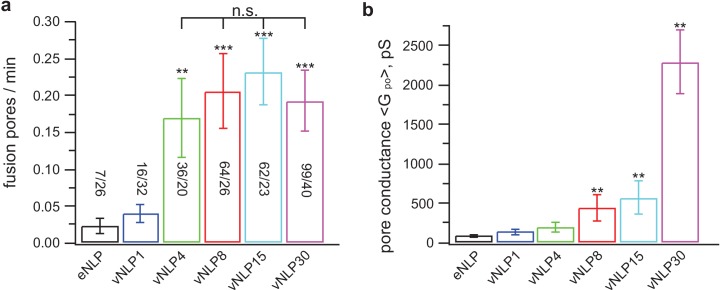
Only a few SNARE complexes are required to nucleate a pore, but more than ~15 are required to dilate it.( a) Pore nucleation rate as a function of total v-SNARE copy number per NLP. Copy numbers per NLP face are approximately 0, 1, 2, 4, 7.5, and 15 for eNLP and vNLP1 through vNLP30, respectively. Pore nucleation requires ~two copies per NLP face and saturates at two to four copies per NLP face. n.s. indicates no statistically significant differences for the mean fusion rates among vNLP4, vNLP8, vNLP15, and vNLP30 samples, as assessed by an analysis of variance (ANOVA) and multiple pairwise comparisons of the group means. The source and analysis files are provided as Figure 5—source data 1. (b) Mean single-pore conductance, Gpo as a function of number of v-SNARE copies loaded into NLPs. Gpo increases rapidly as increasing numbers of v-SNAREs are loaded per NLP. At the maximum value tested, ~15 copies per NLP face, Gpo is far from saturating. The number of pores analyzed/total number of cells is indicated for each condition in (a). **, *** indicate p<0.01 and 0.001, respectively, using the two-sample t-test (a) or the Kolmogorov-Smirnov test (b) to compare with eNLP. Additional pore properties are shown in Figure 5—figure supplement 1. Properties of pores induced using lipid-anchored v-SNAREs are shown in Figure 5—figure supplement 2.DOI:
http://dx.doi.org/10.7554/eLife.22964.01210.7554/eLife.22964.013Figure 5—source data 1.Statistical analysis of fusion rates reported in Figure 5a.Multiple pairwise comparisons of the group means were performed using 1-way analysis of variance (ANOVA) and a multiple comparison test using Matlab. The zipped file includes a matlab file (Figure 5a_FusionPoresPerMin_vs_vNLPcopies.mat) containing the fusion rate data and the results of the ANOVA and multiple comparison tests. Three figures summarize the test results (Figure 5a_ANOVAtable.fig, Figure 5a_ANOVAboxplot.fig, and Figure 5a_multcompare.fig). The analysis procedure and the results are explained in the pdf file Figure 5a_FusionRateAnalysis_summary.pdf.